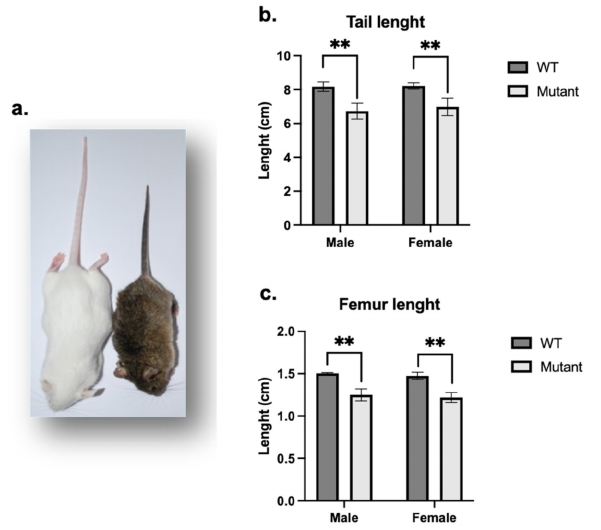
Figure 1. Whole animal and skeletal characteristics of Phex L222P versus WT mice. ( a ) Phex L222P (right) mice are smaller and have shorter body size than their WT littermates (left). Tail ( b ) and femoral ( c ) lengths of age-matched (3 months), sex-matched mutant (light grey bars) and WT (dark grey bars) mice. Error bars indicate standard deviation. Mutant males are hemizygous ( Phex L222P /Y) and mutant females are heterozygous ( Phex L222P / Phex ). Mutant and wildtype mice are on a mixed B6/FVB background. One-way ANOVA test was used to compute p -values; significance was indicated with asterisks (** p -value < 0.01).